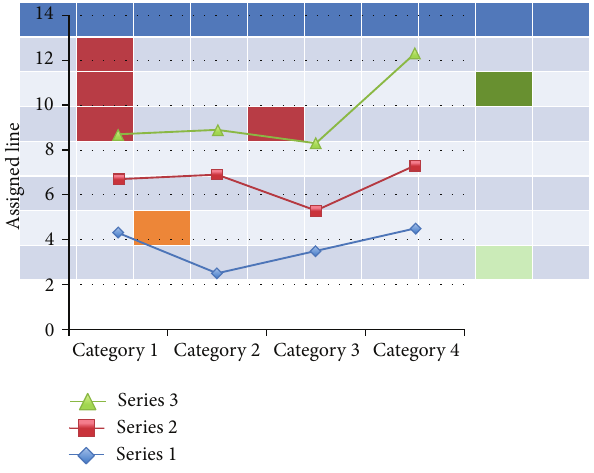
Figure 1: Metabolome profiling. Real-time metabolome profiling by injection of living bacteria, yeast, or mammalian cells into a high- resolution mass spectrometer enabling automated monitoring of several hundred metabolites can be simultaneously quantitatively estimated within minutes in a circuitry displayed in the work published by the Swiss Federal Institute of Technology. Output- fluxes of ∼ 300 compounds using automated monitoring in 15–30 s cycles over several hours are possible. The figure is a simplified transposition of single data points from hundreds of possible analyses (squares, randomly highlighted with colors) becoming linked using bioinformatics into series and categories meaningful for exploration